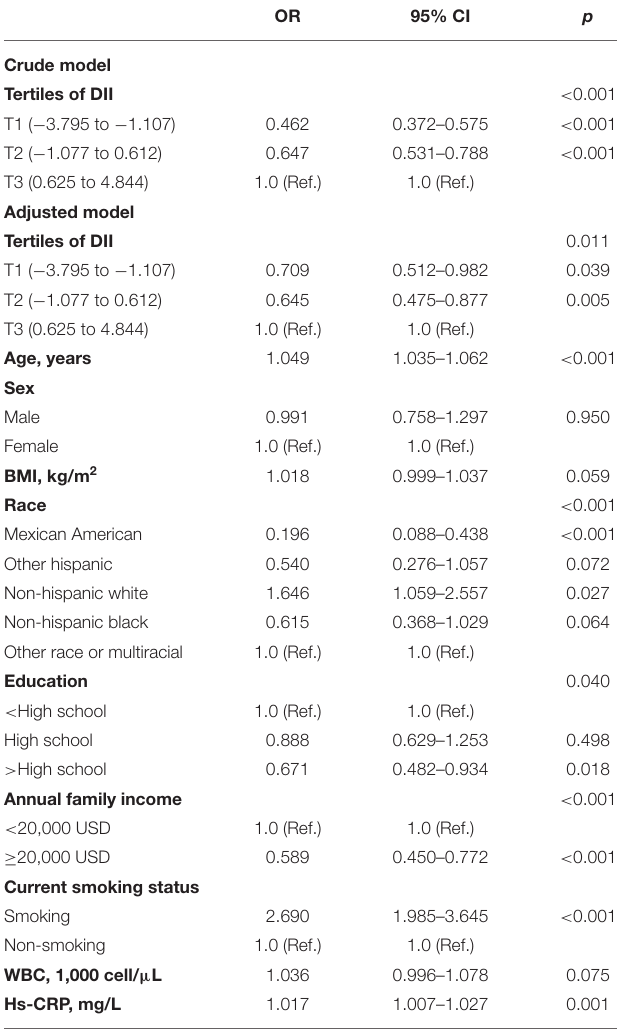
TABLE 3 | Logistic regression analysis of DII for COPD in participants above 40 years old in NHANES